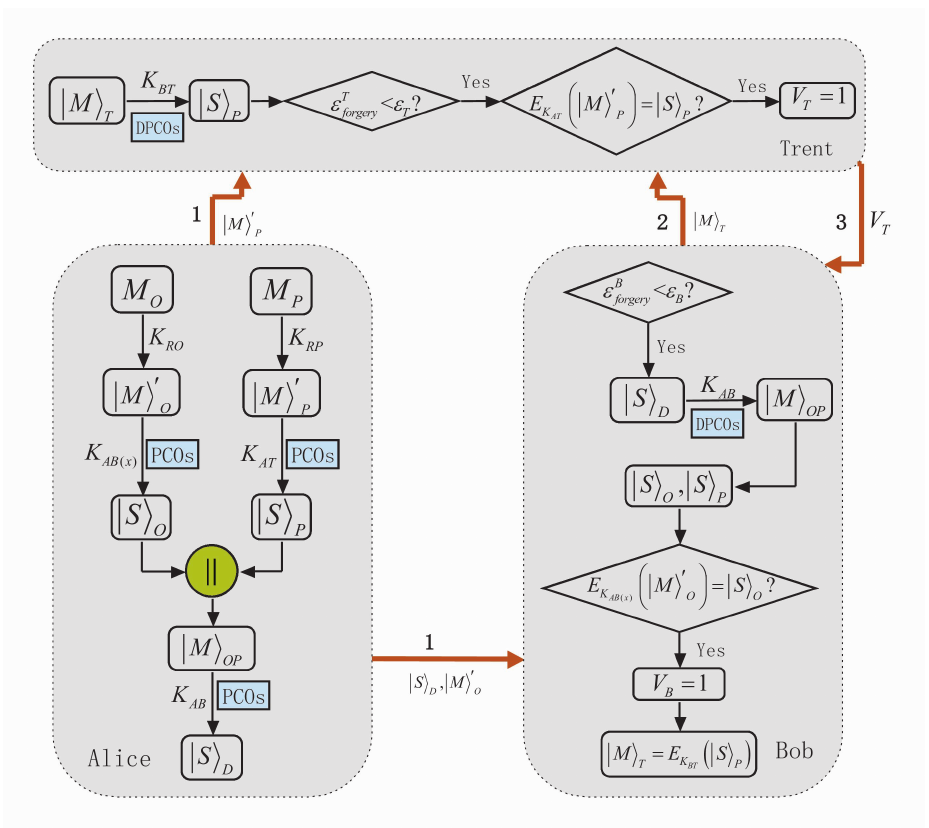
Figure 1. Schematic representation of the quantum dual signature scheme. PCOs and DPCOs separately stand for encryption and decryption based on CPCO. || represents the connection